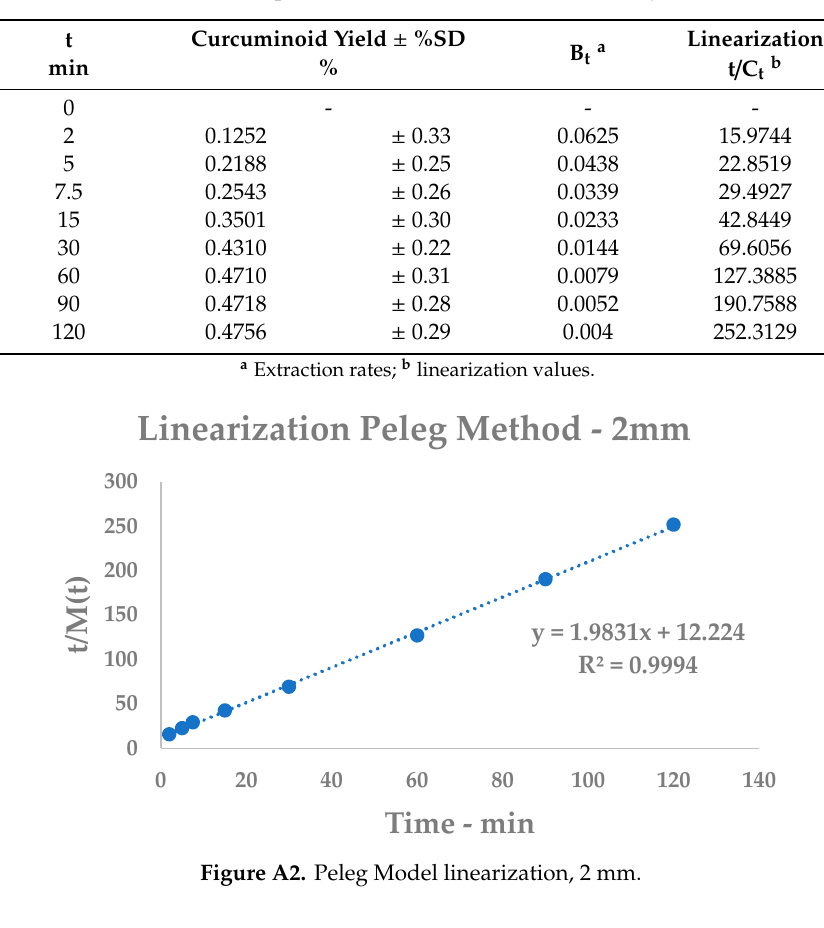
Table A2. Experimental UAE of 2 mm Curcuma longa L.